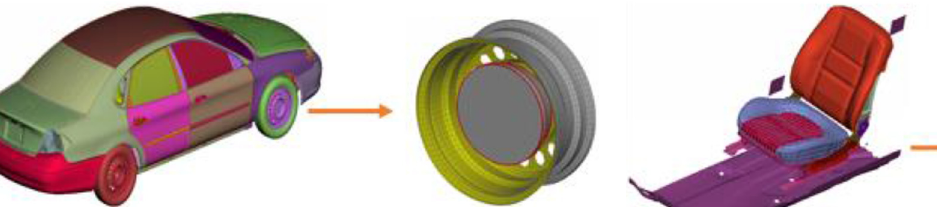
Fig. 8. Script output with R-Tree approach for full car assembly.